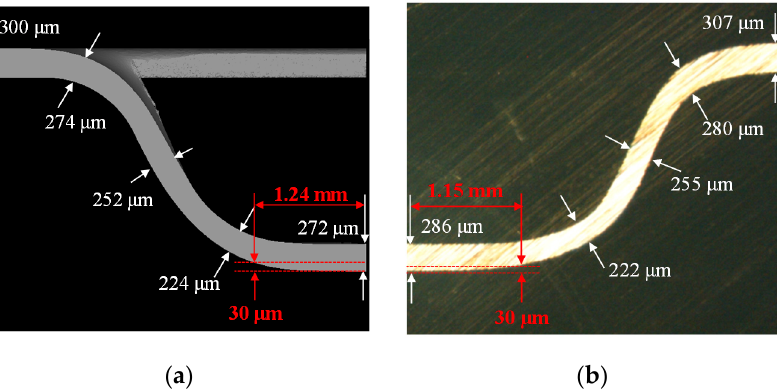
Figure 16. Comparison of contact length and thickness distribution of slot for two-stage forming: ( a ) FE analysis and ( b ) experiment.